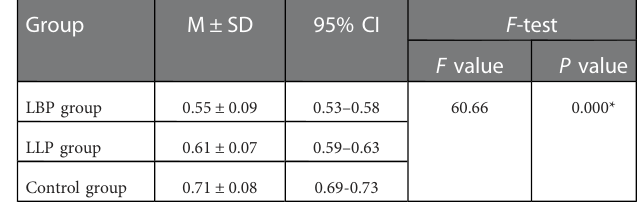
TABLE 2 Comparison of the maximum CSA indices of PM among three